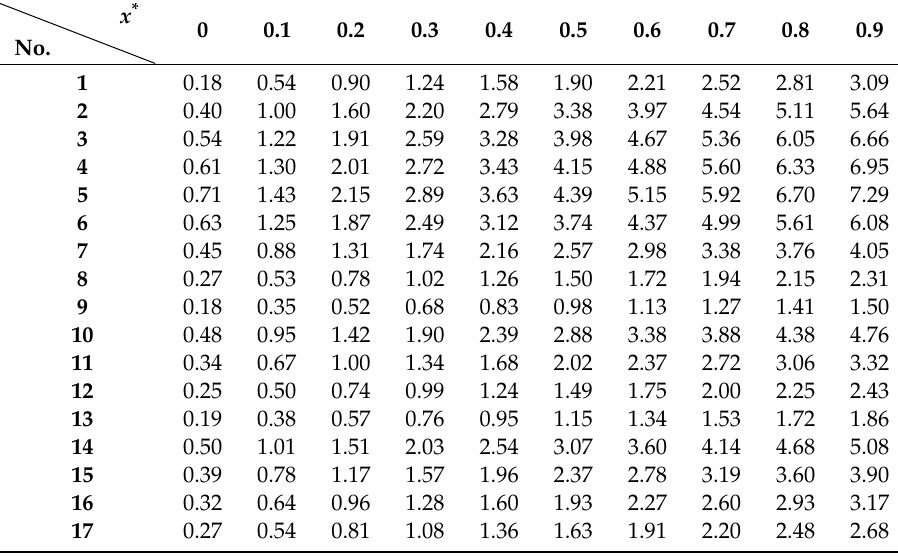
Table 3. The relative error (%) by maximum flow depth for the entire 17 tests.